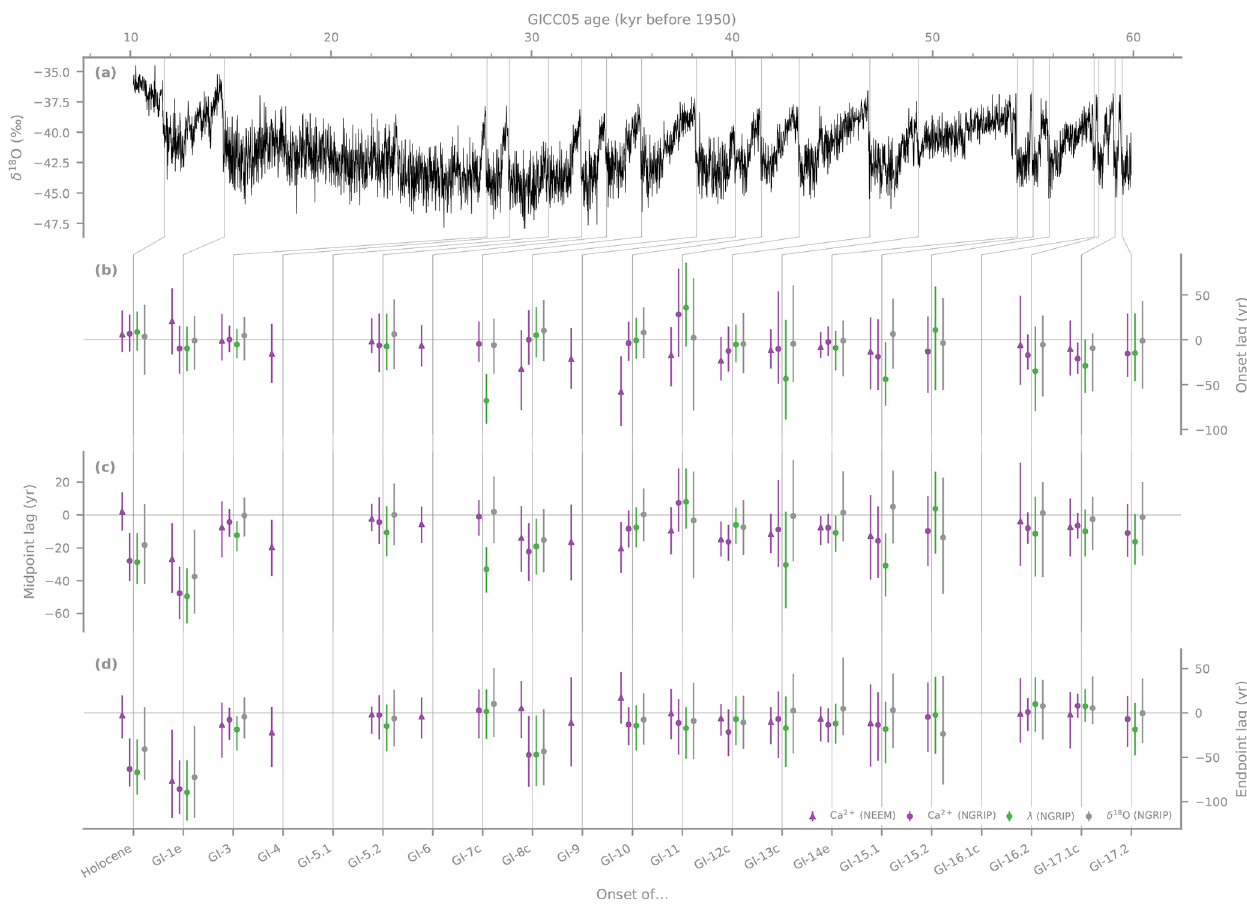
Figure 3. Timing differences for the individual interstadial onsets: (a) the NGRIP δ 18 O record, (b–d) timing difference of NGRIP Ca 2 + , layer thickness ( λ ) and δ 18 O records, as well as the NEEM Ca 2 + record relative to the transition in the respective Na + records at the onset (b) , midpoint (c) and end (d) of the transition. No timing results are given for transitions where there are data gaps in one of the necessary datasets. Error bars show the marginal posterior 5th and 95th percentiles and the symbol the marginal posterior median. Note the different axis scaling for the start, midpoints and endpoints. All inferred absolute timings, the transition durations and the lags relative to Na + can be found in the